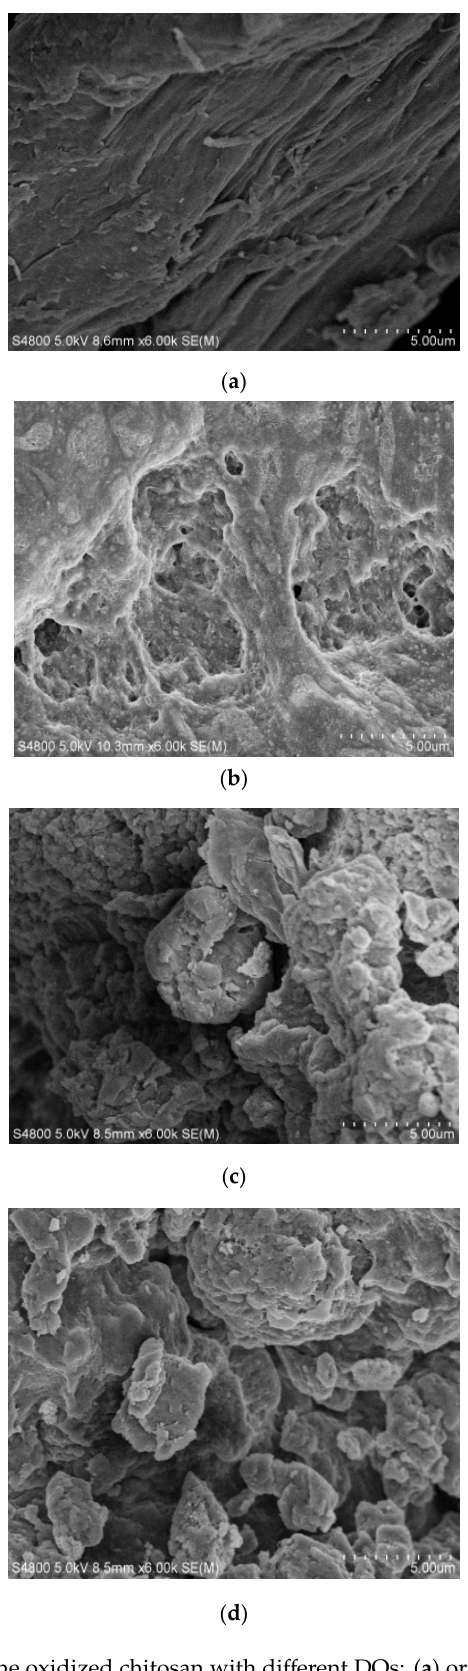
Figure 3. SEM images of the oxidized chitosan with different DOs: ( a ) original chitosan; ( b ) porous chitosan; ( c ) oxidized chitosan with 29.4% of DO; and ( d ) oxidized chitosan with 55.5% of DO.